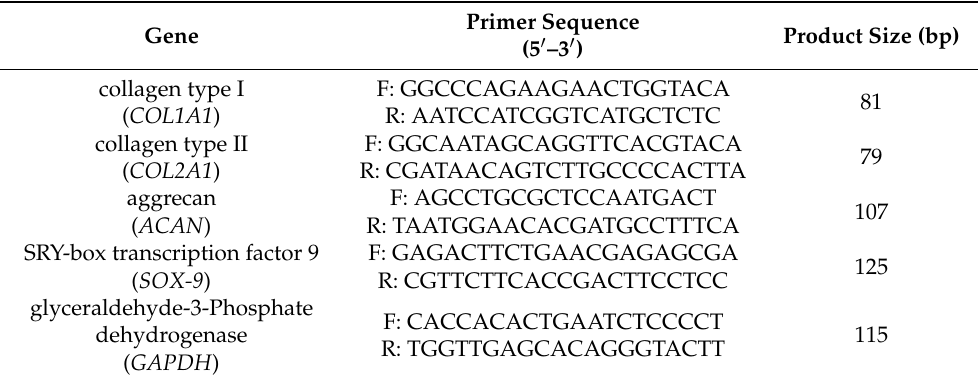
Table 1. List of primers for RT-qPCR analysis. The primer sequences for collagen type II and aggrecan were developed based on literature data [30], while primer sequences for collagen type I, SRY-box transcription factor 9, and glyceraldehydes-3-phosphate were developed using Primer-BLAST tool that is available online on the website of National Center for Biotechnology Information (NCBI) [31].